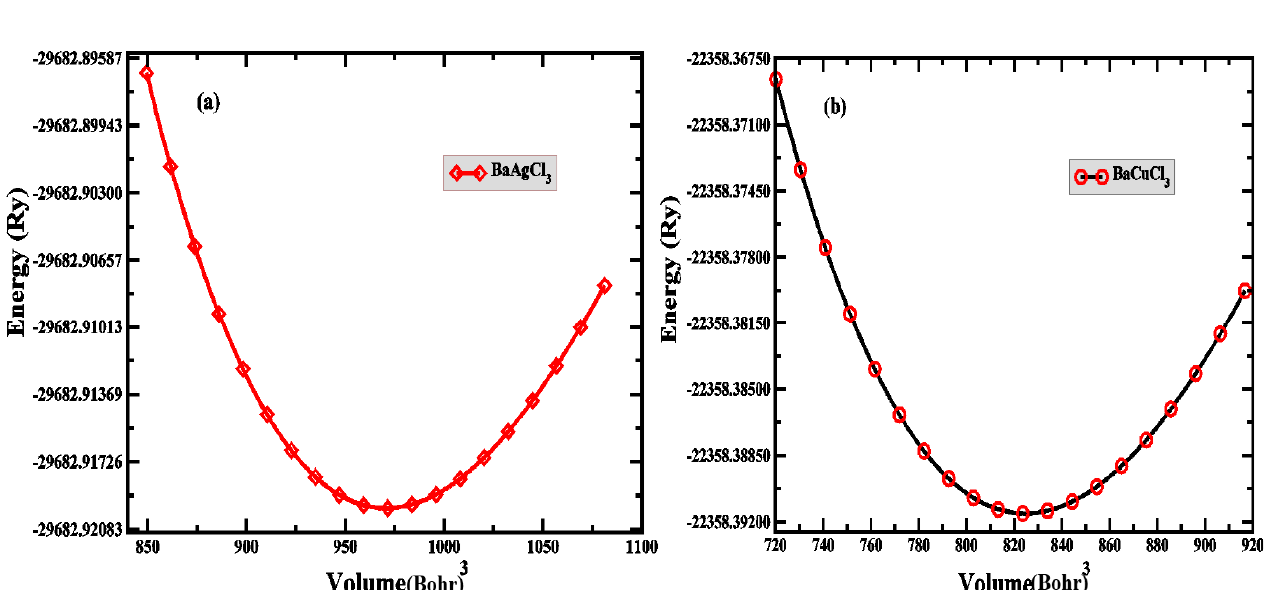
Figure 2. Illustration of volume optimization curves for ( a ) BaAgCl 3 and ( b ) BaCuCl 3 .